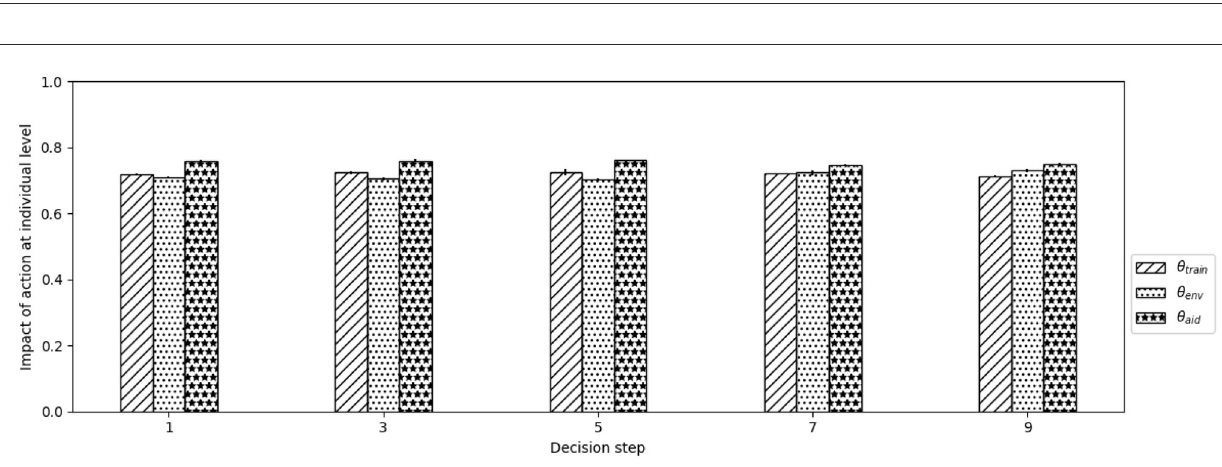
FIGURE9 Mean values of the level of impact of each type of action (i.e., θ -parameters) chosen by the institution on odd decision steps during the training stable period. Error bars stand for standard